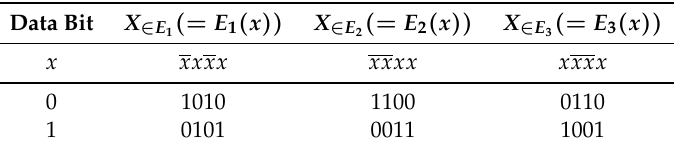
Table 1. Three types of proposed encoding